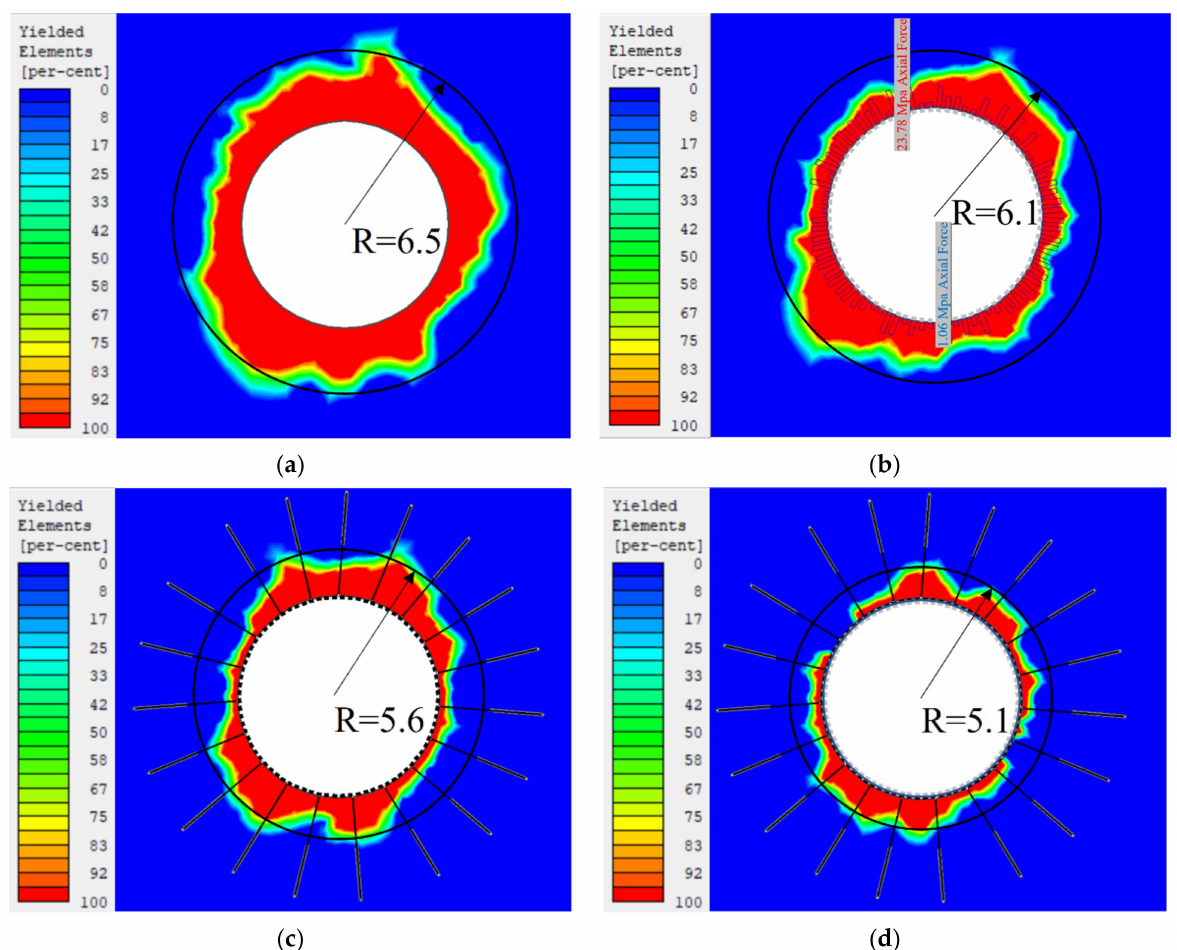
Figure 8. ( a ) Without support; ( b ) lining support; ( c ) bolt shotcrete support; ( d ) bolt shotcrete and lining